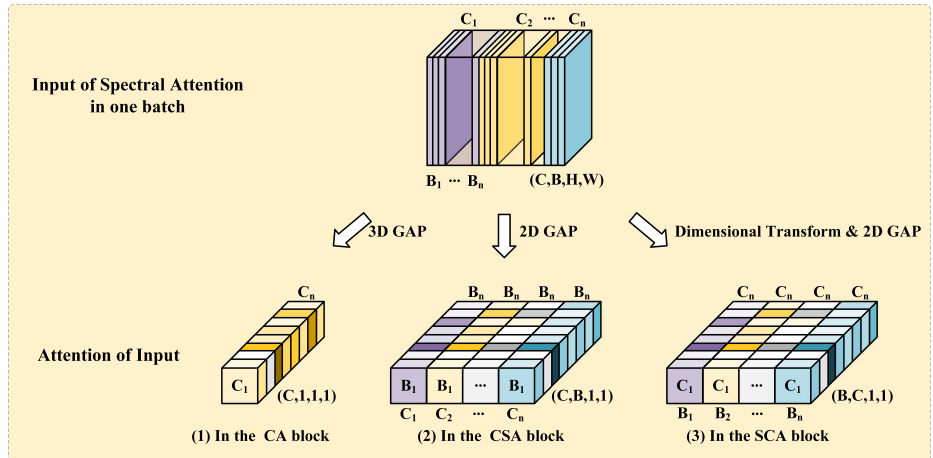
Figure 5. The three different versions of the spectral attention, i.e., CA block, CSA block and SCA block. We finally select the SCA with the best performance as the module of SSCA block.